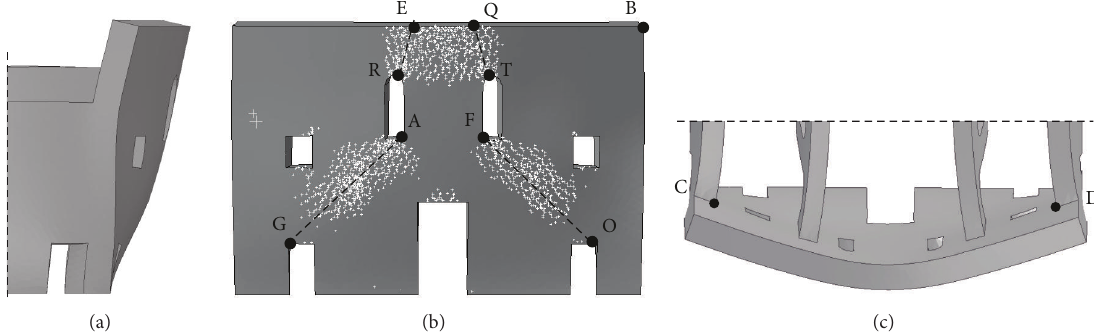
Figure 17: Representation of the fac¸ade mechanism: (a) lateral view of the amplified deformed shape, (b) front view with the corresponding cracking pattern, and (c) top view of the amplified deformed